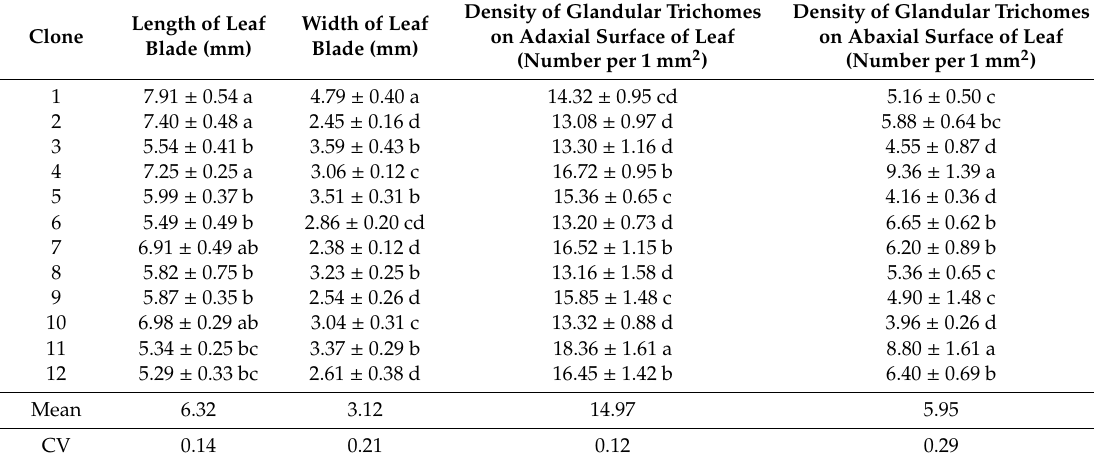
Table 4. Leaves parameters (mm) and density of glandular trichomes on leaves (number per 1 mm 2 ). Length of Leaf Clone Blade